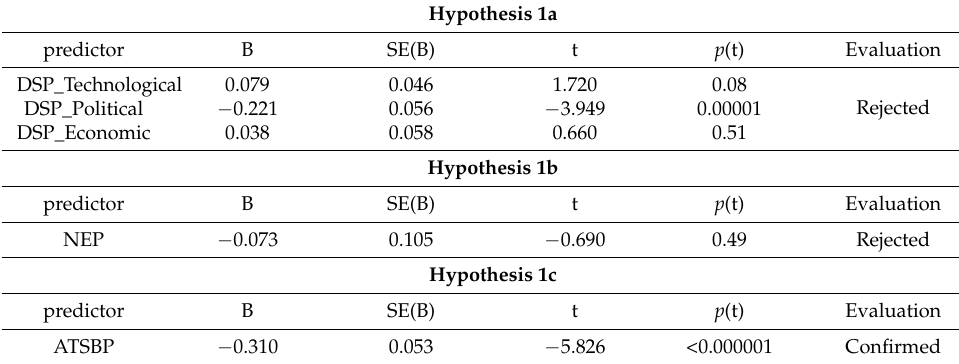
Table A4. Hypotheses and